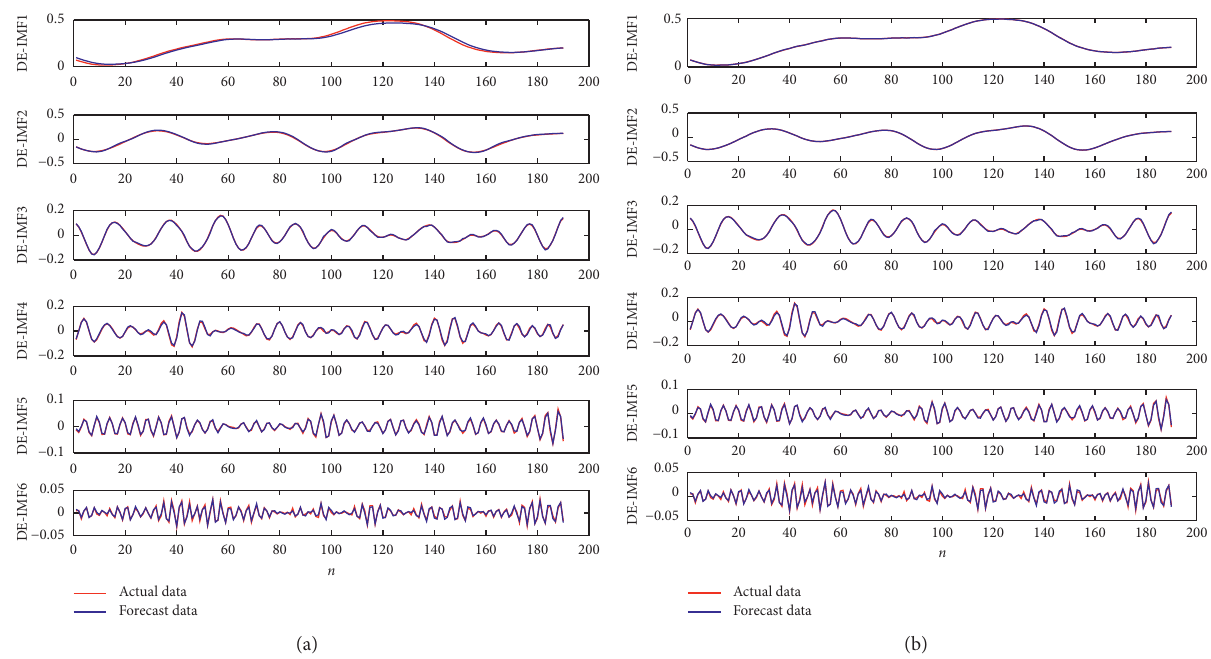
Figure 12: (a) VMD-DE-ASVR prediction results of each component; (b) VMD-DE-ELM-ASVR prediction results of each component.